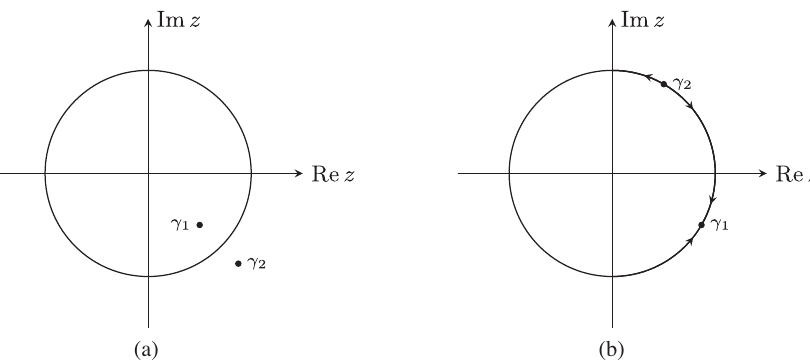
FIG. 6. Fixed point distribution in real time. (a) In the nonheating phase, one fixed point is inside the unit circle, while the other one is outside. (b) In the heating phase, both fixed points are on the unit circle. One is attractive, and the other is